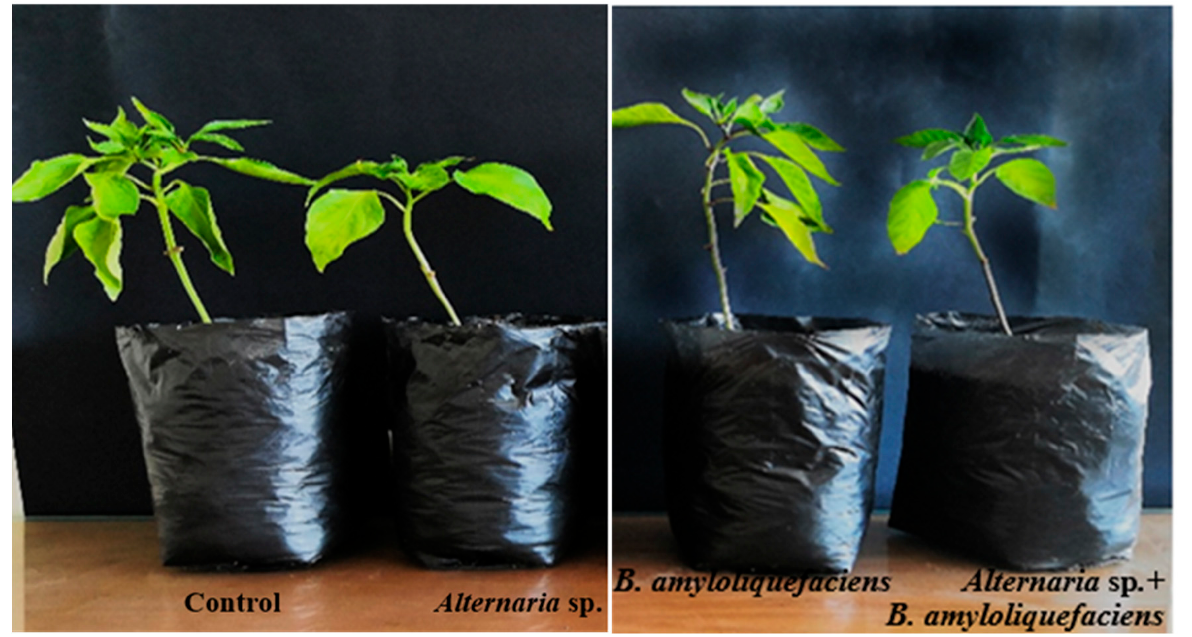
Figure 9. In vivo antagonistic activity of B. amyloliquefaciens against Alternaria sp. infection of pepper plants.